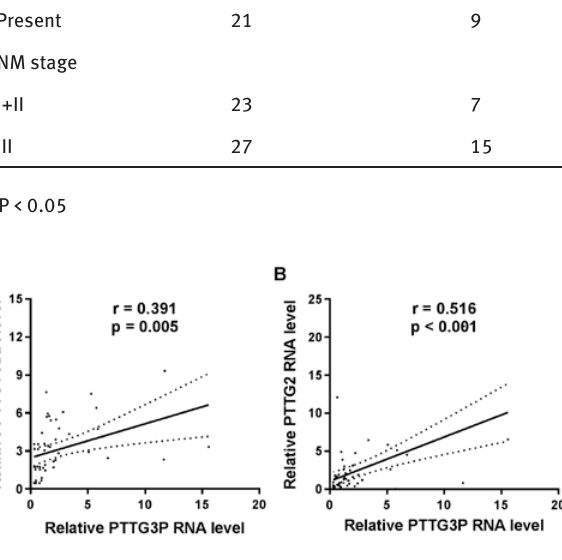
Figure 2: PTTG3P expression is positive correlated with PTTG1 and PTTG2 expression.